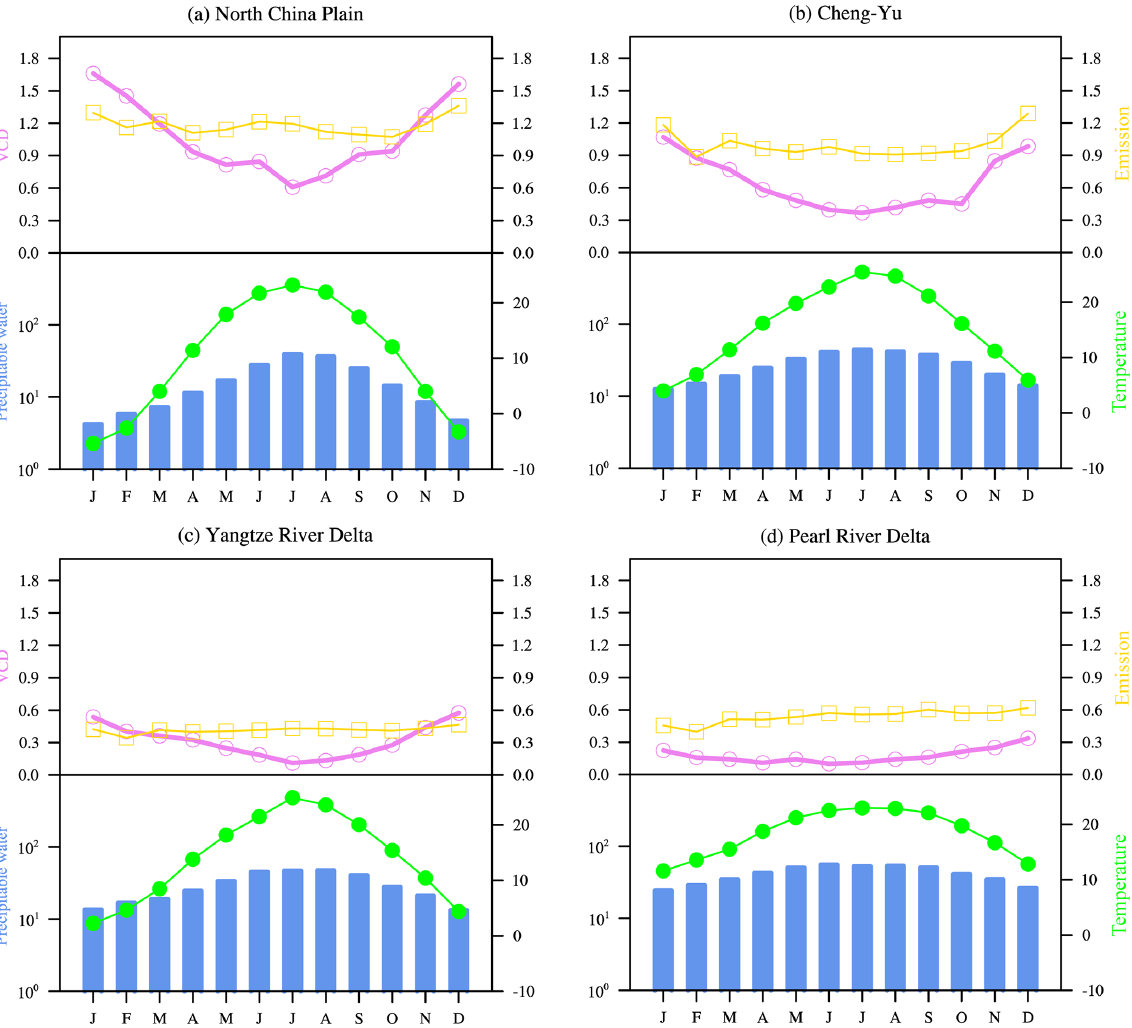
Figure 4. Annual cycle of SO 2 VCD (unit: DU, pink line), MEIC SO 2 emission (unit: tkm − 2 , yellow line), precipitable water (unit: kgm − 2 , blue bar) and temperature at 925hPa (unit: ◦ C, green line) for NCP (a) , CY (b) , YRD (c) and PRD (d)